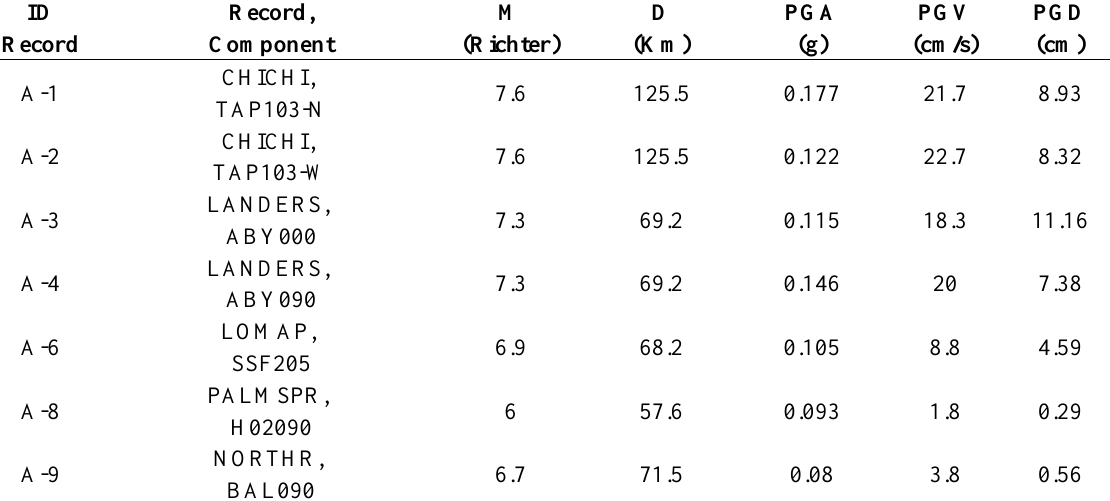
Table 4. Set of ground motion records in soil type A.